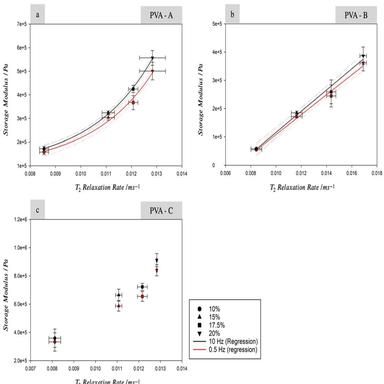
Storage Modulus plotted against MR T2 Relaxation Rate for 0.5 Hz (red), and 10 Hz (black) for PVA-A (a), PVA-B (b), and PVA-C (c). Error bars show 95% confidence (n = 6). Regression lines for 0.5 Hz (red), and 10 Hz (black) are also given; dashed lines show 95% confidence intervals for regression. (For interpretation of the references to colour in this figure legend, the reader is referred to the web version of this article.)